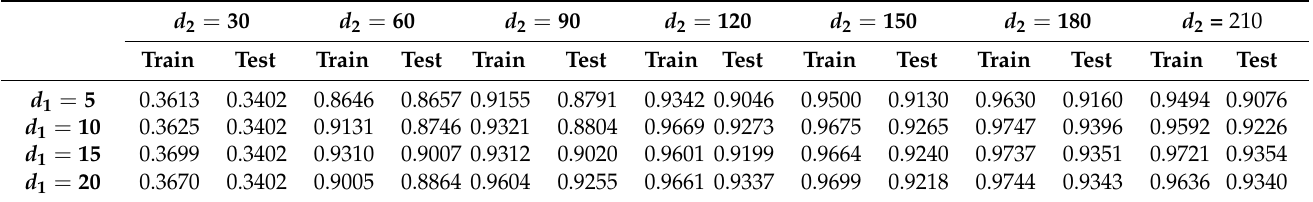
Table 1. The accuracy of target identification in training data and test data under different values of d 1 and d 2